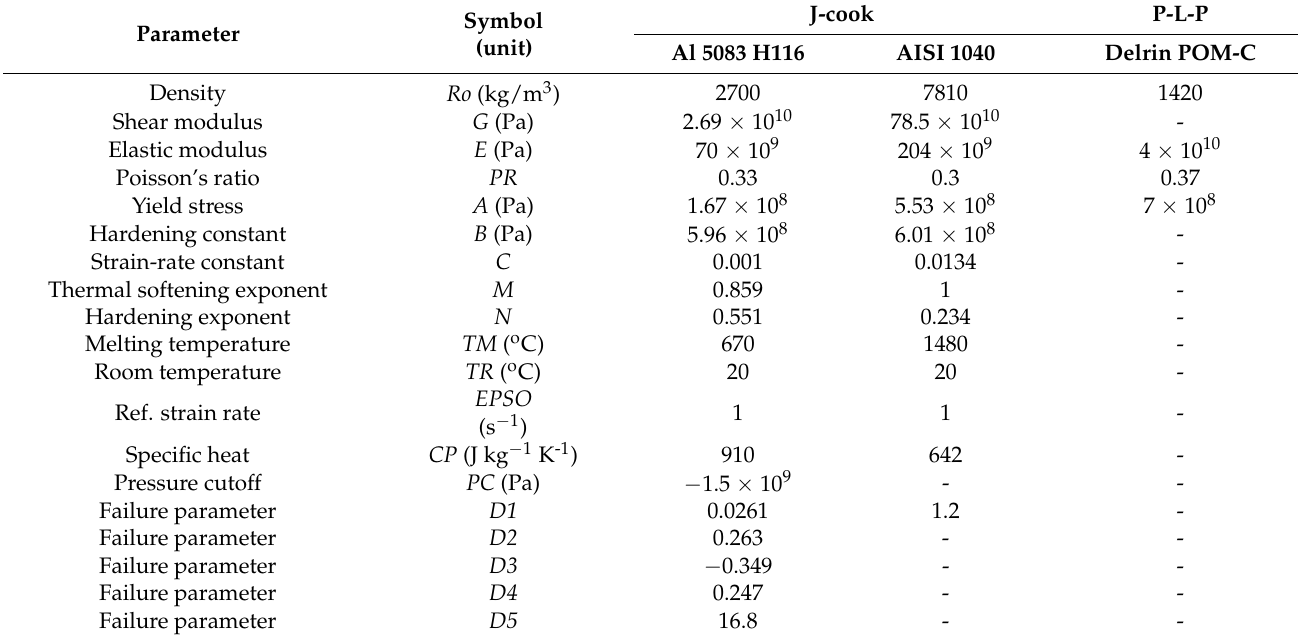
Table 3. Johnson–Cook and piecewise linear plasticity model parameters for the aluminum, steel and polymer tested in LS-Dyna